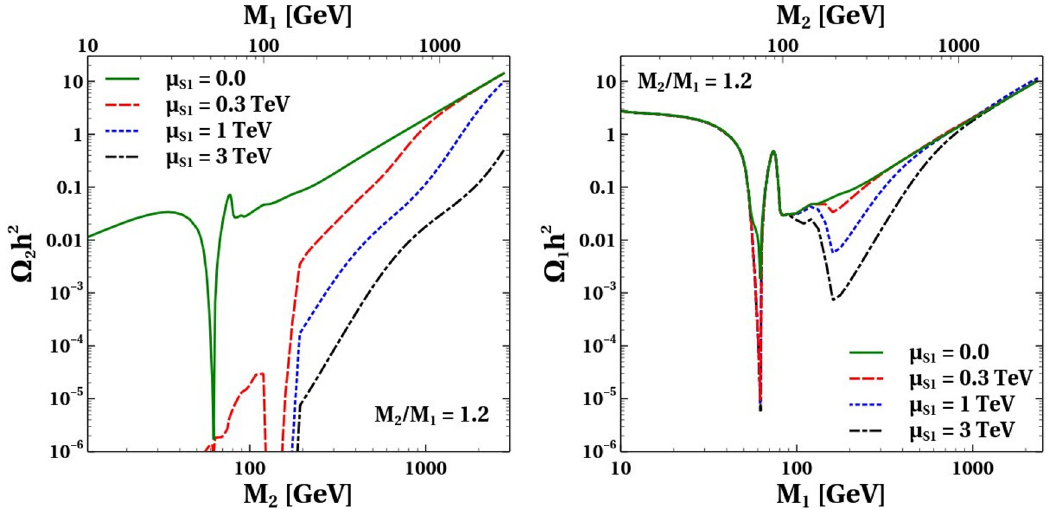
Figure 6 . The e(cid:11)ect of (cid:22) S 1 on (cid:10) 2 (left panel) and (cid:10) 1 (right panel) for M 2 =M 1 = 1 : 2.